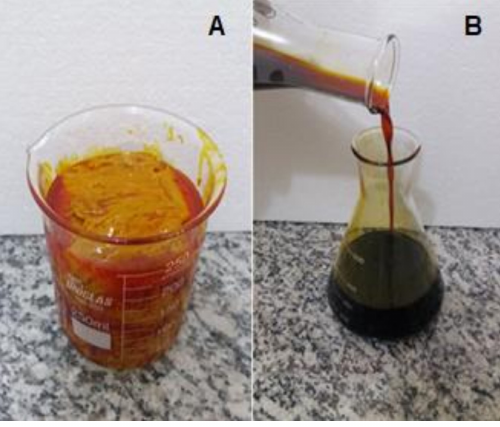
Figure 3. ( A ) Buriti oil soapstock and ( B ) biodiesel from buriti oil